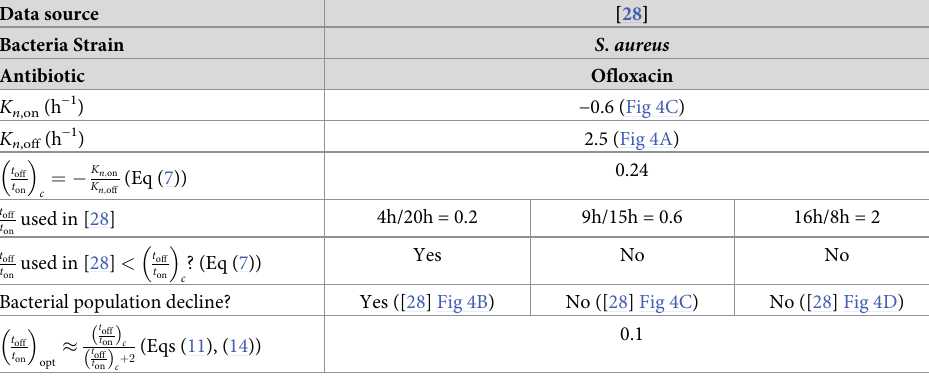
Table 2. Literature data analysis to test proposed theory for pulse dosing regimen